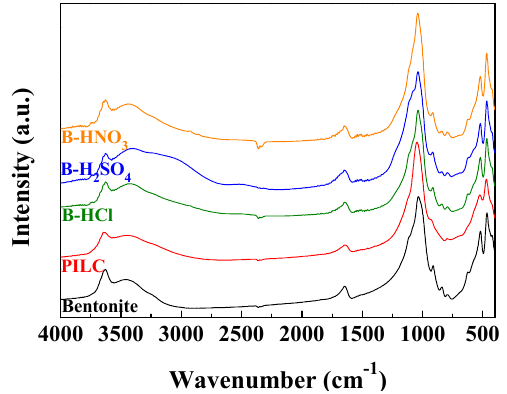
Figure 2. FTIR spectra of raw bentonite, PILC, B-H 2 SO 4 , B-HNO 3 and B-HCl.